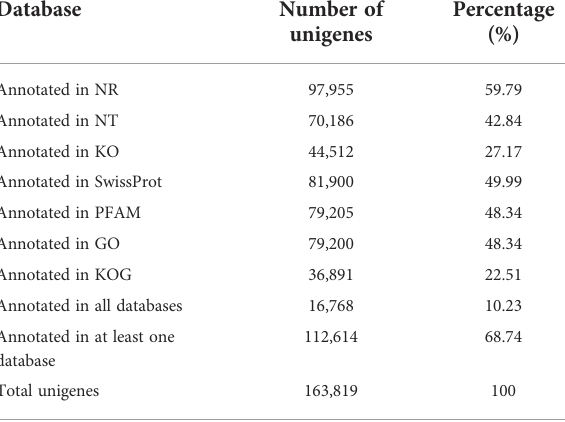
TABLE 3 Annotation rate in each